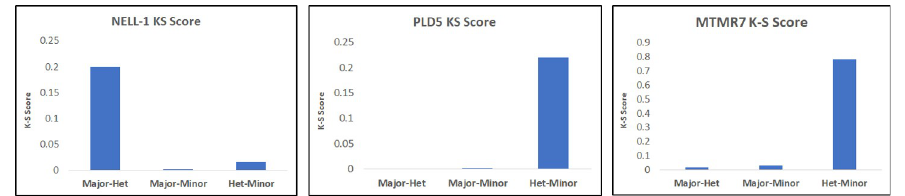
Fig 7. The Kolmogorov-Smirnov scores for the genetically stratified phenotype distributions (two shown in Fig 8). The scores, indicating the similarity between the distributions, show the dominance of the major allele for NELL1 and the dominance of the minor allele for PLD5, and MTMR7 (not shown in Fig 8).